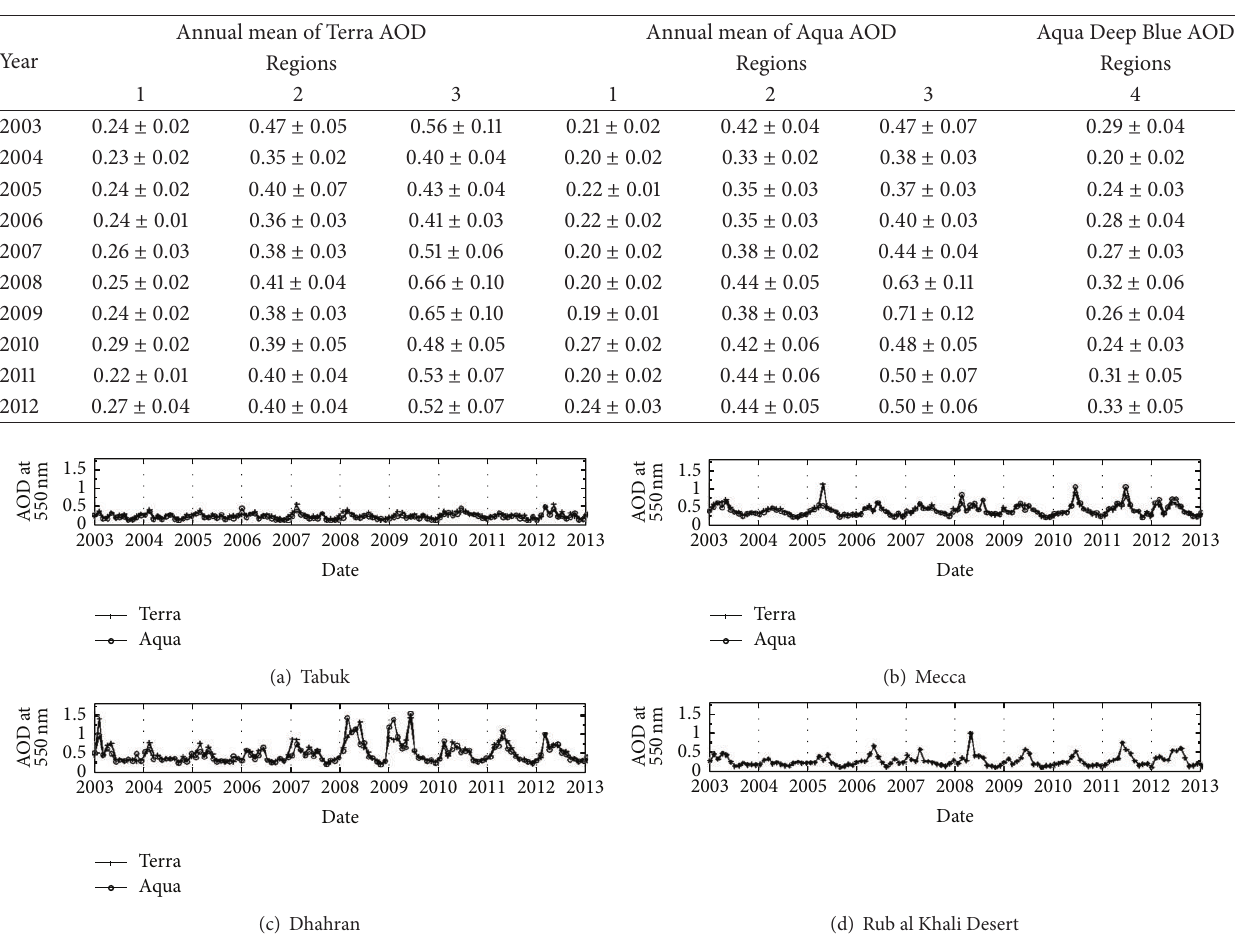
Table 1: Annual AOD means for Terra and Aqua over regions 1–3 and for Aqua Deep Blue over region 4 (desert).